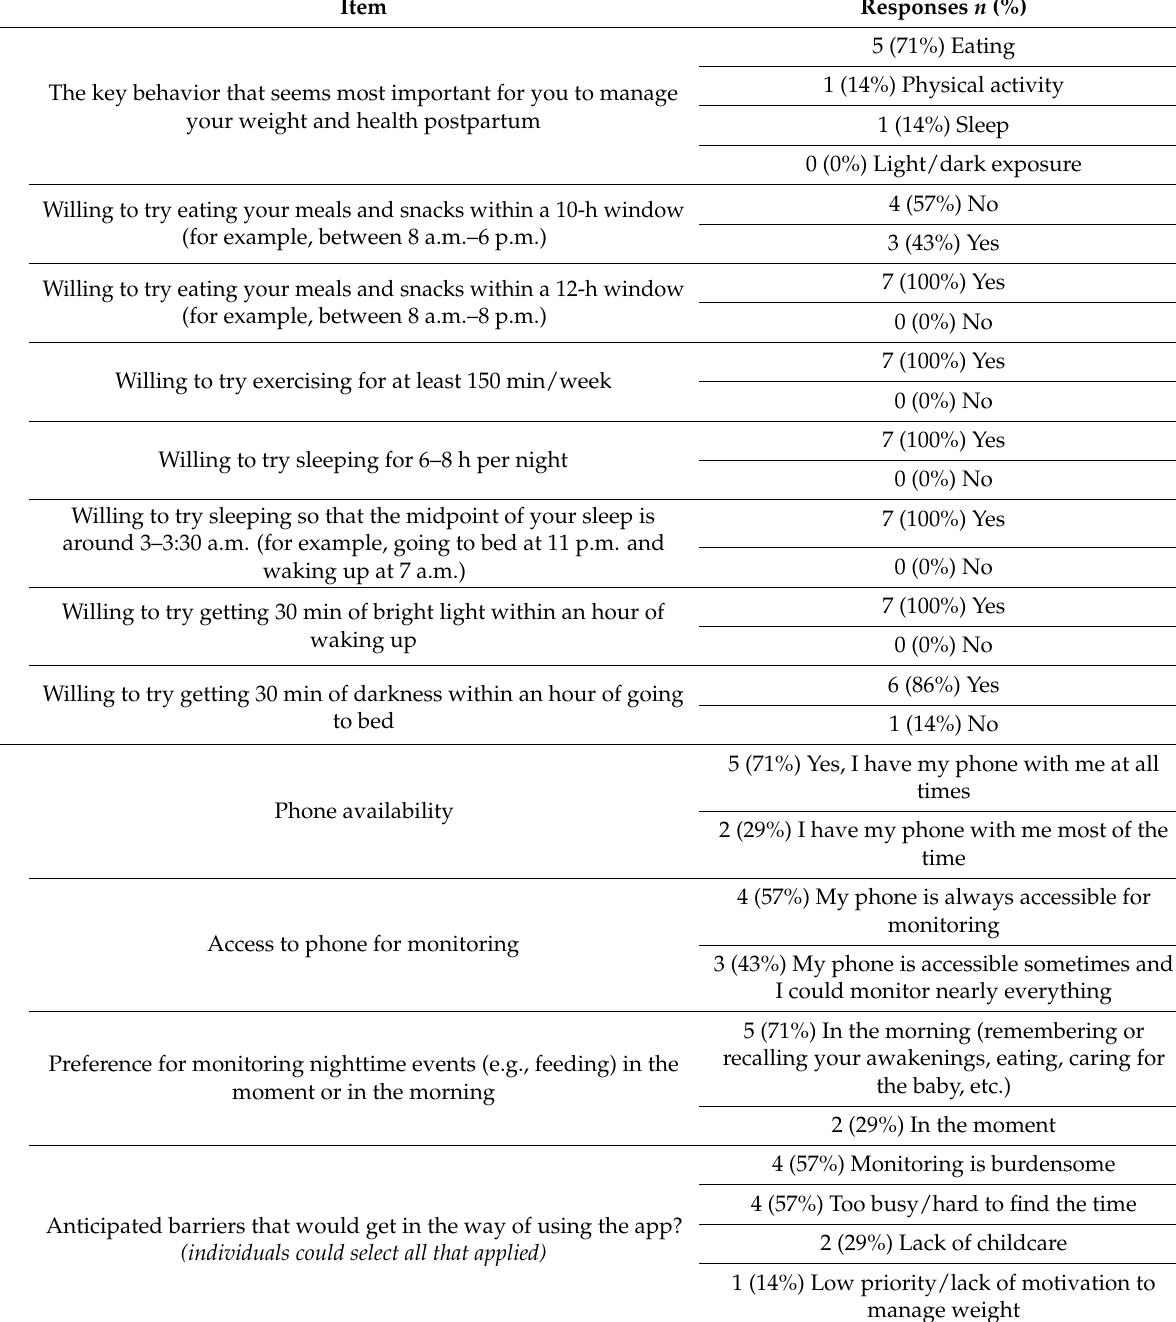
Table 3. Quantitative feedback on the ClockWork intervention model and digital monitoring tools from postpartum individuals who began pregnancy with a BMI ≥ 25 ( n =